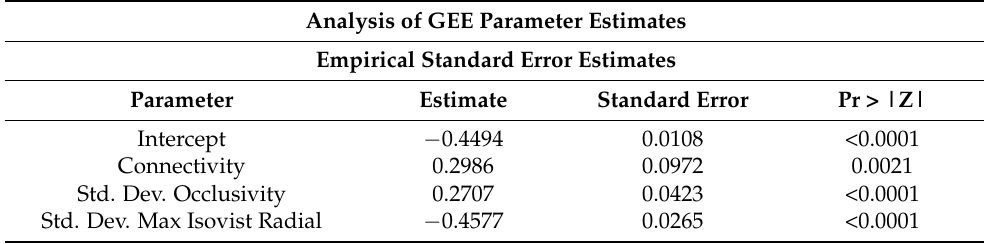
Table 1. Output of negative binomial regression representing the effects of connectivity and visual measures on breaking and entering.